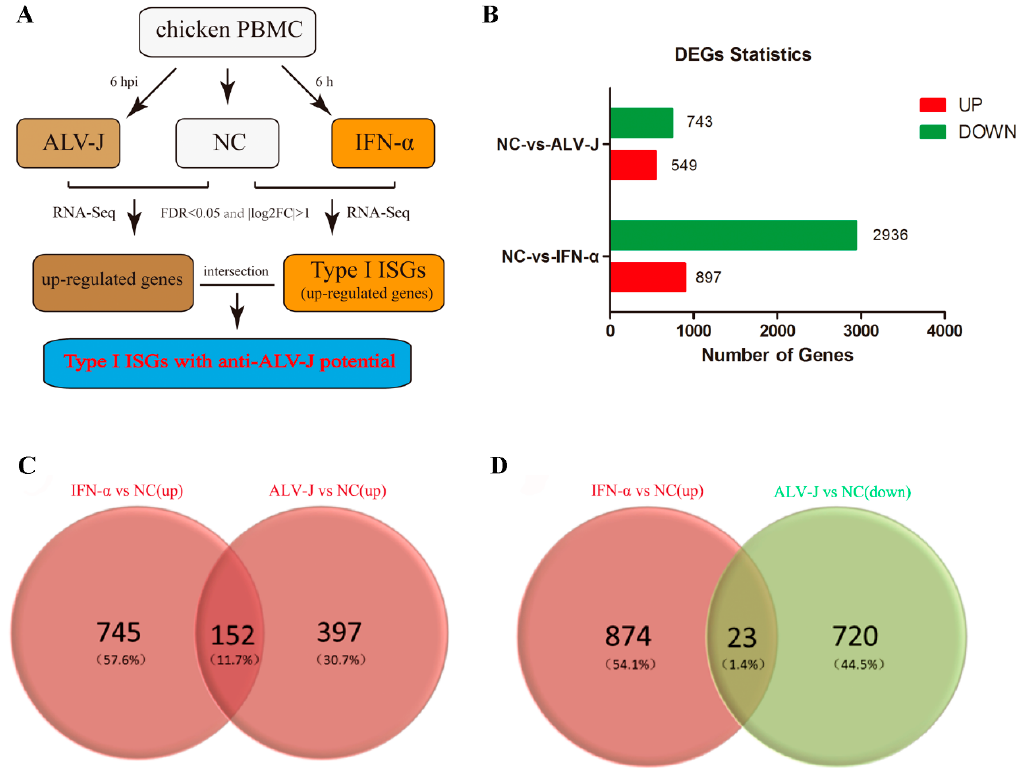
Figure 1. Identification of potential anti-ALV-J ISG candidates. ( A ) Summary of the strategy used to identify chicken type I ISGs and anti-ALV-J ISG candidates. ( B ) DEGs in PBMC cells infected with ALV-J, and DEGs in PBMC treated with chicken IFN- α . ( C ) Venn diagrams of up-regulated DEGs in